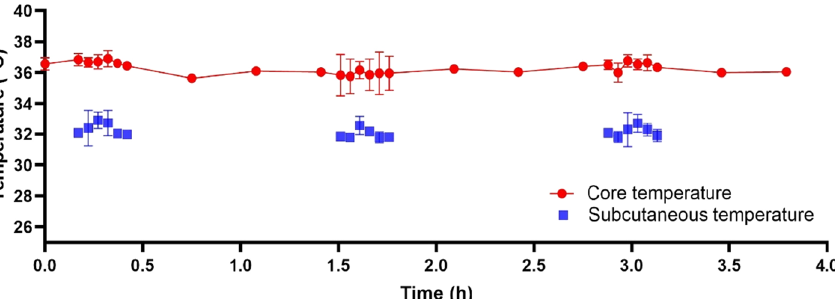
Figure 3. Changes in the core and subcutaneous temperature following pulsed cooling procedure in mice. The core temperature is measured with a rectal probe every 3 min during pulsed cooling, and with an infrared non- contact thermometer gun every 20 min during recovery. Data are presented as mean ± SD (n =